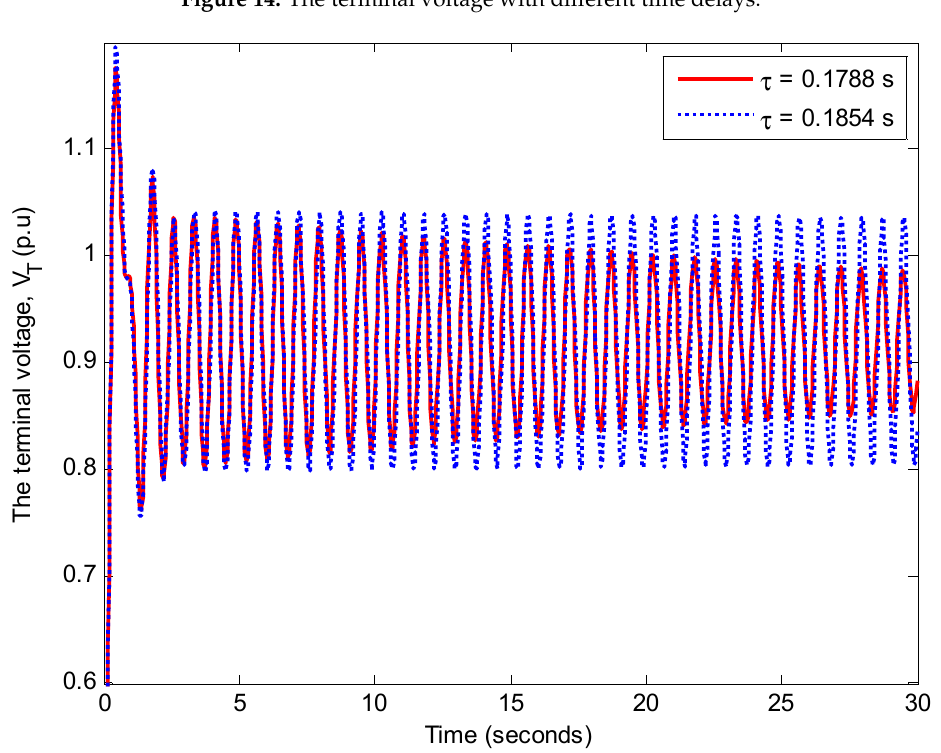
Figure 15. The terminal voltage with different time delays.